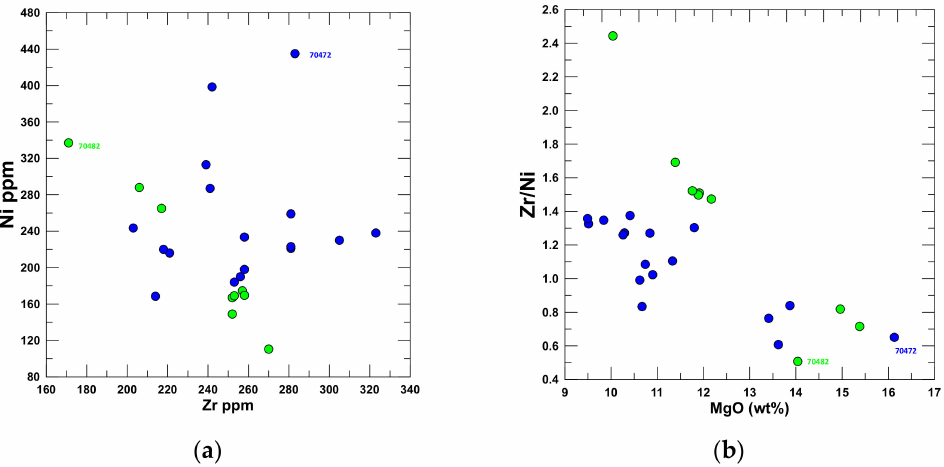
Figure 6. The Ni ppm ( a ) and Zr/Ni values ( b ) versus Zr ppm for the Christmas Island lava series. Outliers 70472 has accumulated olivine and xenolithic material whereas 70482 was recovered by dredging during FR9_87 and most likely represents a slightly different parental magma composition of the